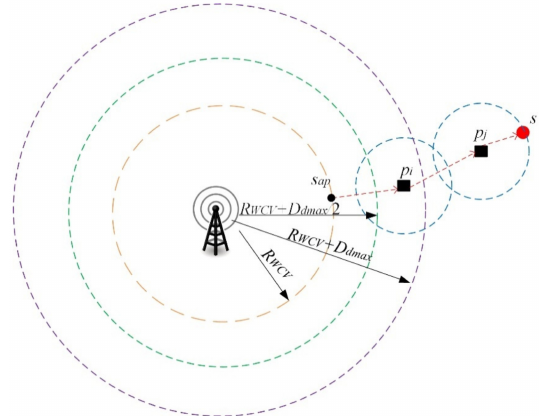
Figure A3. There exists an available flight path from a releasing stop to the target node that is covered by a pad and connected by pads located in an area outside the WCV region (Case